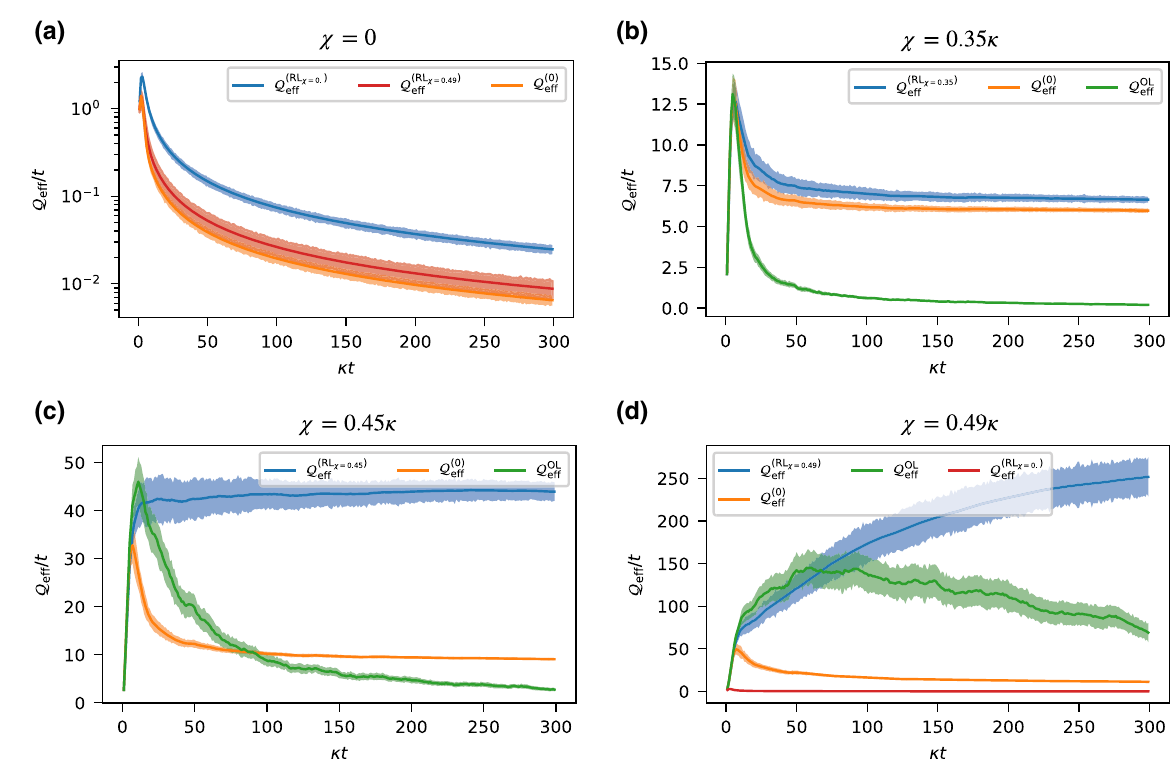
FIG. 6. Performance of the control strategies as a function of time, quantified by the effective quantum Fisher information Q eff divided by time, and for different values of χ : (a) χ = 0; (b) χ = 0.35 κ ; (c) χ = 0.45 κ ; (d) χ = 0.49 κ . Notice that in (a) the scale of the y axis is logarithmic and that the curve corresponding to the open-loop control strategy Q (OL) values are almost negligible. Furthermore in (a),(d) an extra red curve, corresponding to the agent trained at, respectively, χ = 0.49 and χ = 0, has been added. The results are obtained by simulating N = 1000 trajectories with time step dt = 0.001 /κ , by fixing the other parameters as ω = 0.1 κ and η = 0.9, and by considering as an initial state a thermal state with n th = 5 and initial first-moment vector ¯ r c ( 0 ) = ( 0, 0 ) .